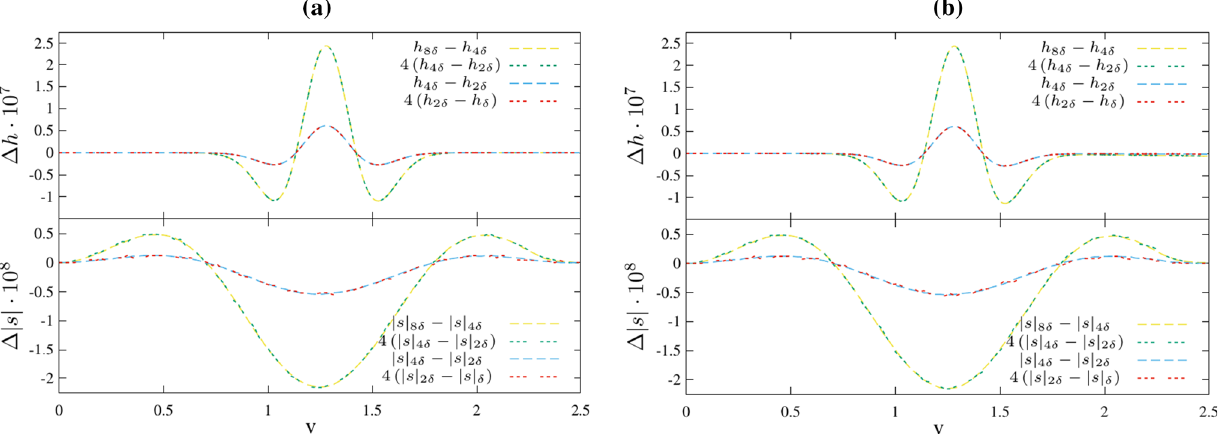
δ = 10 − 4 ) and their multiples were obtained along the same hypersur- faces of constant u as in Fig. 17 for a Evolution 1 and b Evolution